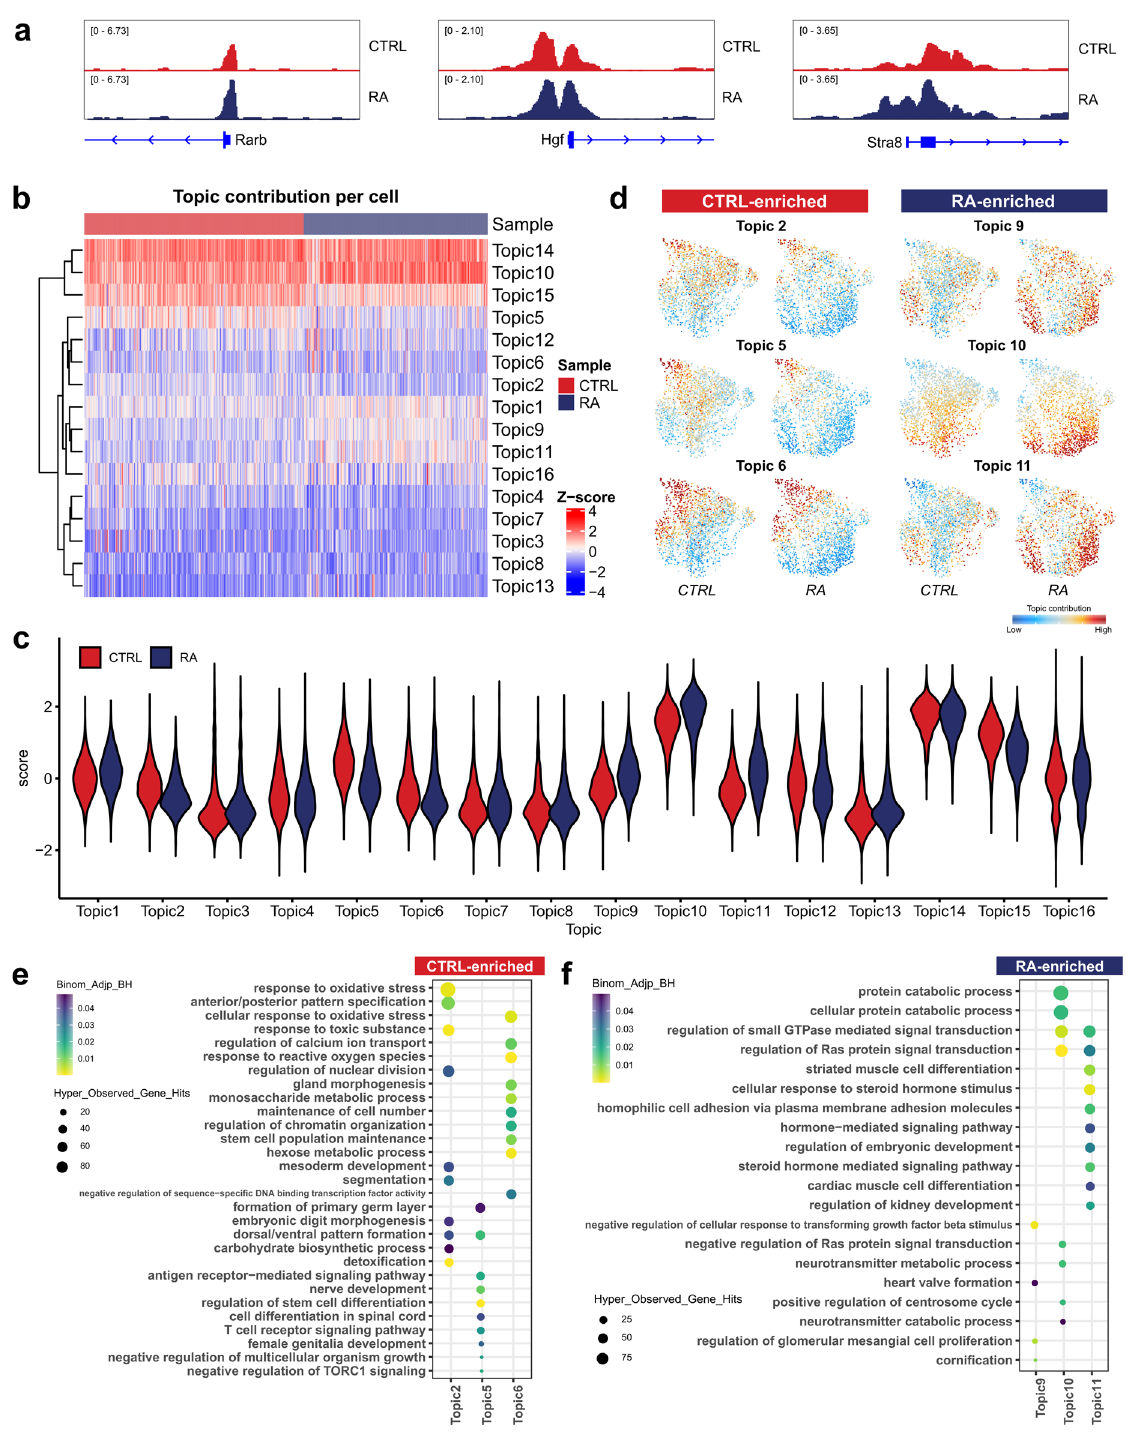
Figure 4. Regulatory topics associated with GSC response to retinoic acid (RA). ( a ) Normalized pseudo- bulk accessibility tracks showing RAR/RXR direct target genes comparing control and RA treatment groups. ( b ) Heatmap showing Topic-cell enrichment revealed by cisTopic analysis. ( c ) Violin plot of the normalized topic score of topics. ( d ) UMAP color-coded by the normalized topic score of selected CTRL-enriched and RA-enriched topics. ( e ) GREAT analysis of regions included in CTRL-enriched topics. ( f ) GREAT analysis of regions included in RA-enriched